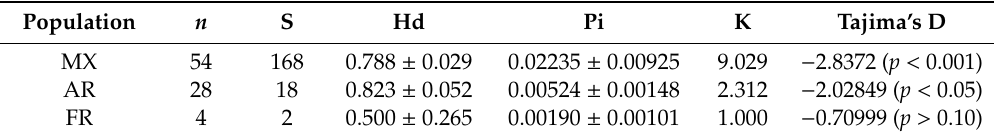
Table 6. Parameters of genetic diversity in populations of A.